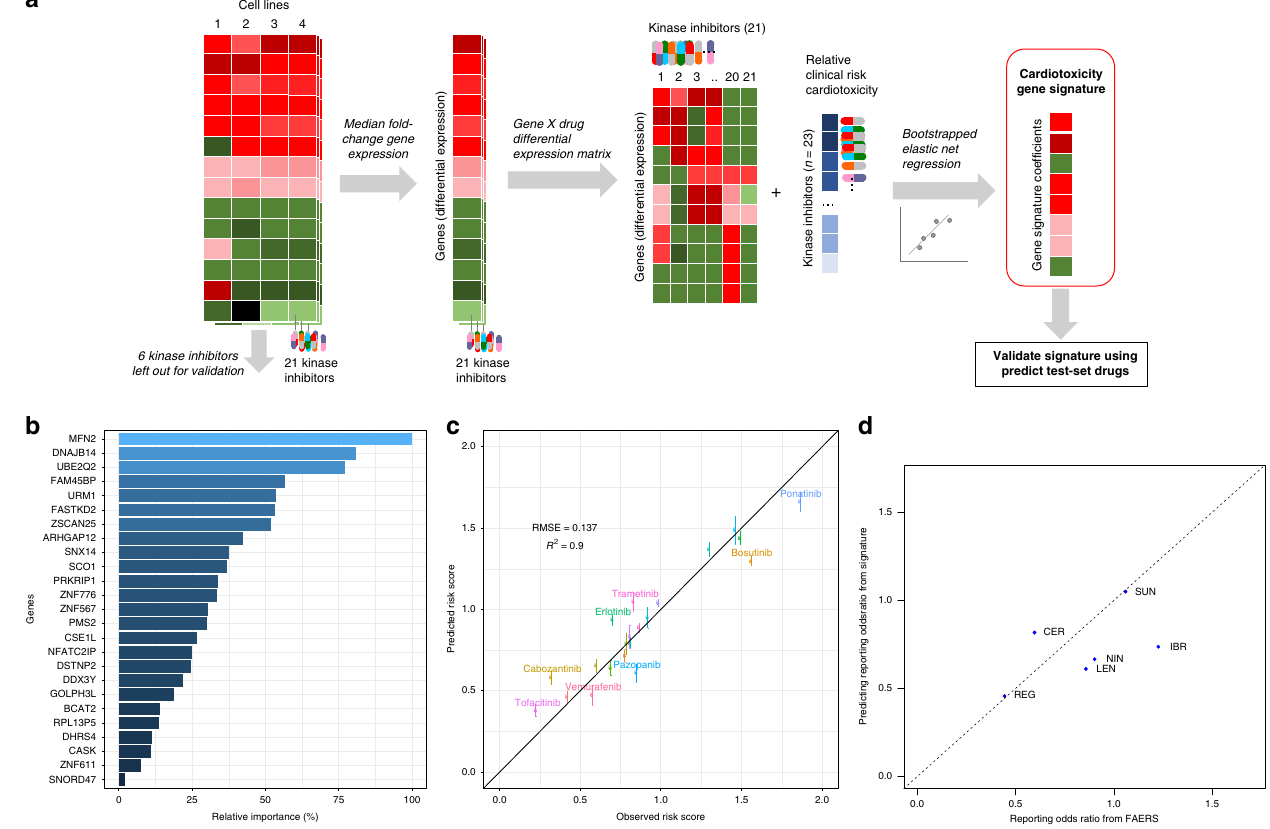
Fig. 4 Regression analysis for transcriptomic signatures to predict clinical risk. a Overview of processing and elastic net regression analysis of transcriptomic data in combination with FAERS-derived clinical risk scores. b Transcriptomic signature genes selected to predict cardiotoxicity risk score indicating their variable importance. c Observed and predicted risk scores from the elastic net cross- validation analysis (mean and standard deviation). d External validation of the signature for six kinase inhibitors: regorafenib (REG), sunitinib (SUN), ibrutinib (IBR), lenvatinib (LEN), nintendinib (NIN), and